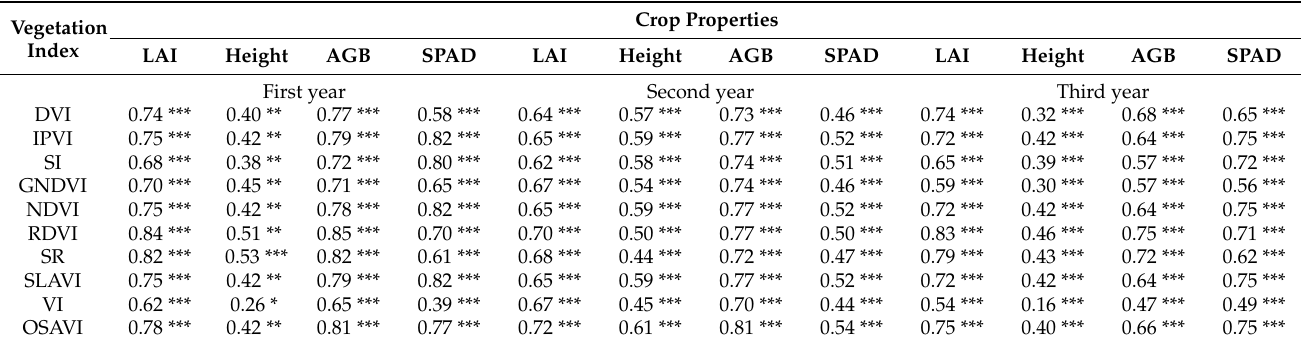
Table 7. Coefficient of determination for the association between various vegetation-SRIs obtained from QuickBird satellite image and Egyptian wheat characteristics collected from the study site. Crop Vegetation Index